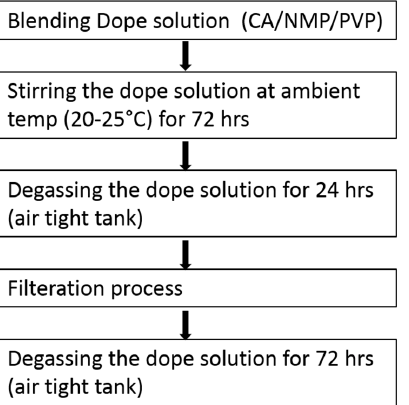
Figure 2. Steps involved in dope formation. CA, cellulose acetate; NMP, N -methyl-2-pyrrolidone; PVP, Polyvinylpyrrolidone.